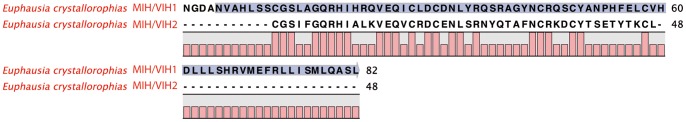
Alignment of the partial protein sequences of the pro-peptides of MIH/VIH from d'E. crystallorophias.The complete mature peptide of MIH/VIH1 is highlighted in blue. Only a partial sequence for MIH/VIH2 was identified.